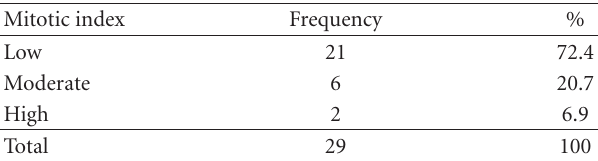
Table 4: Mitotic index of the invasive epithelial component ( n =